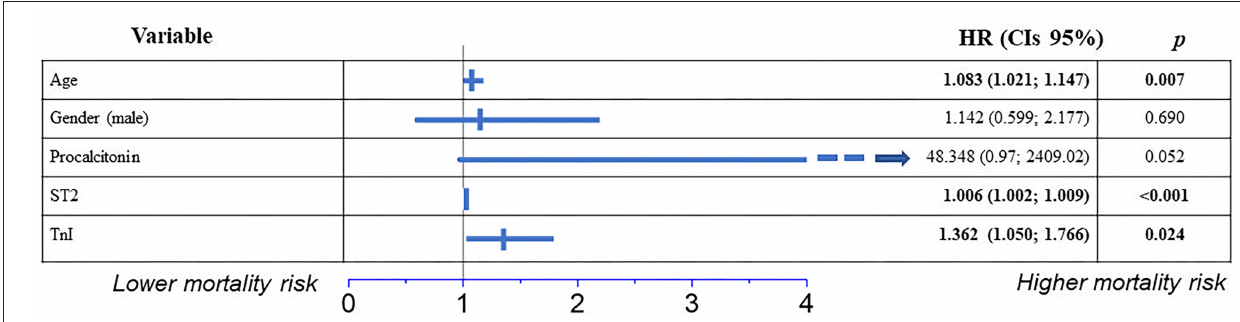
FIGURE 4 | Independent predictors of post-hospital 1-year FU mortality in patients hospitalized with COVID-19, in a multivariate survival analysis using Cox’s regression model. Results are reported as hazard ratios (HR) and 95% confidence intervals (CIs).